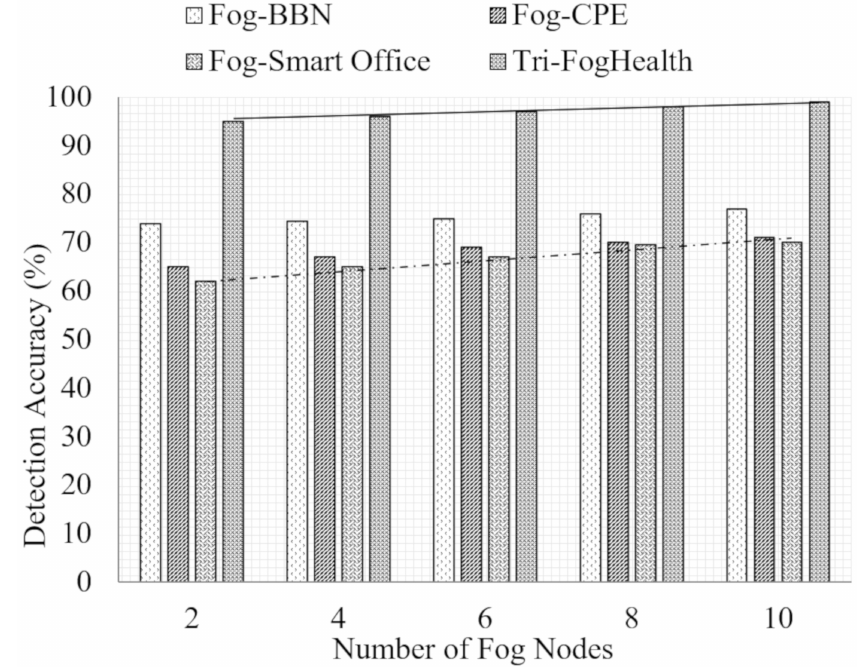
Figure 13. Comparison of Detection